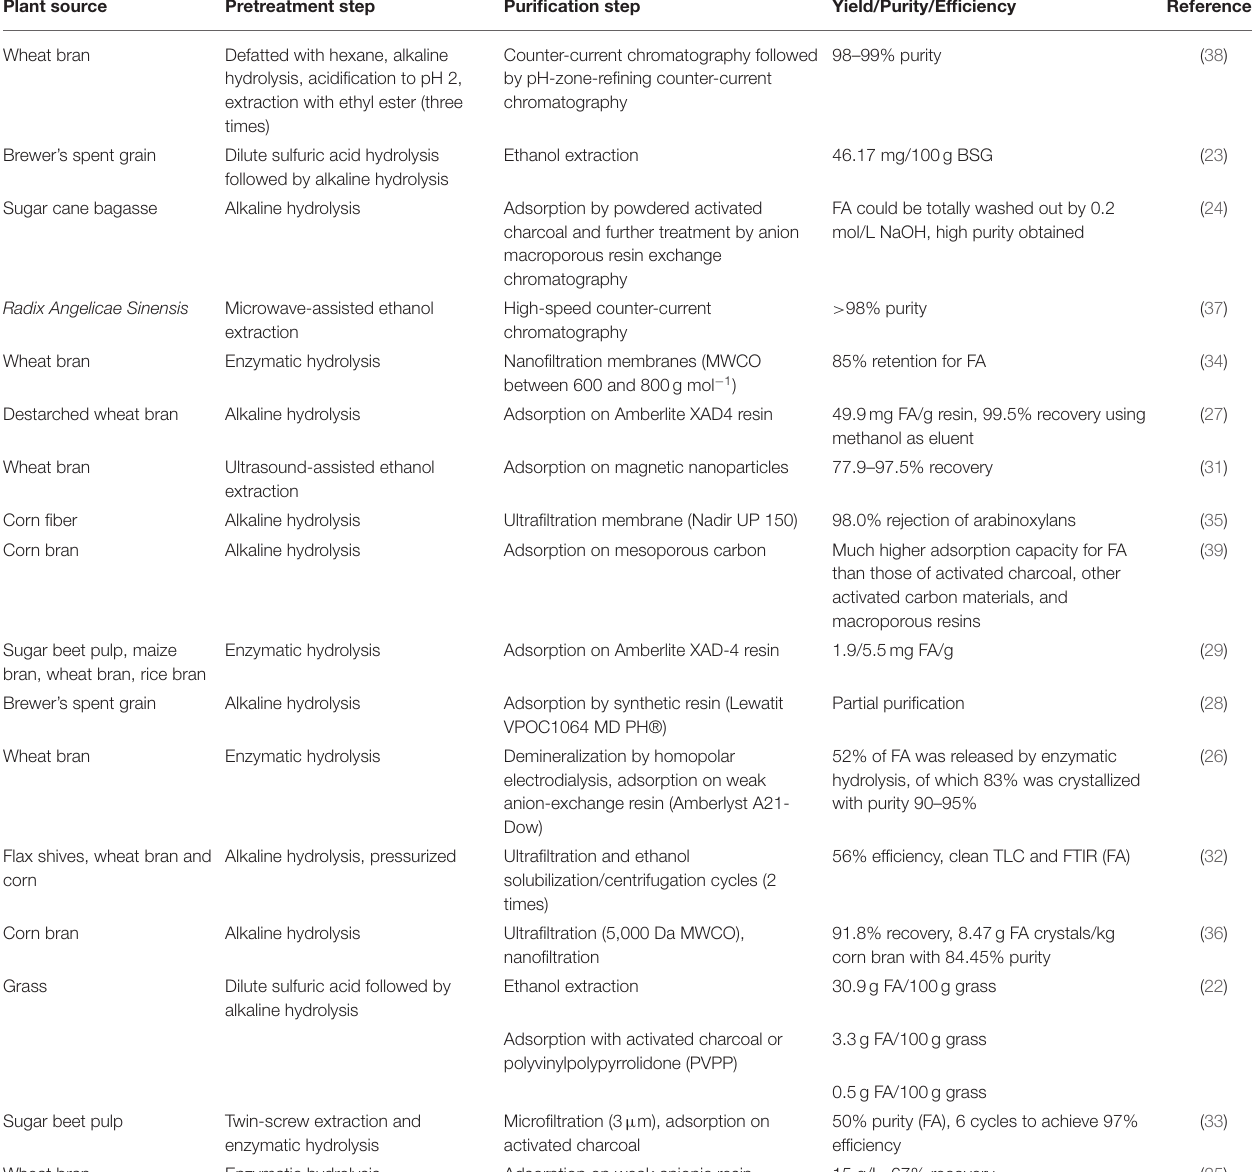
TABLE 1 | Examples of reported methods on the pretreatment of plant biomass and further purification of